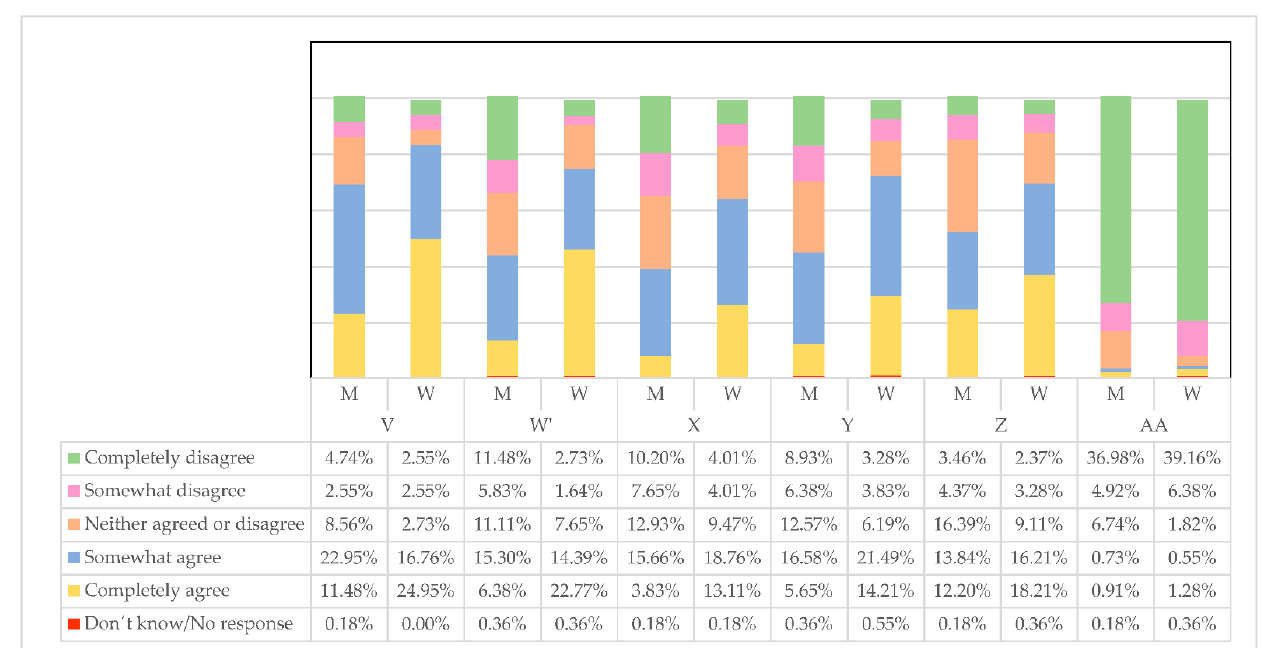
Figure 4. Perception of female business leadership. Source: Own elaboration.